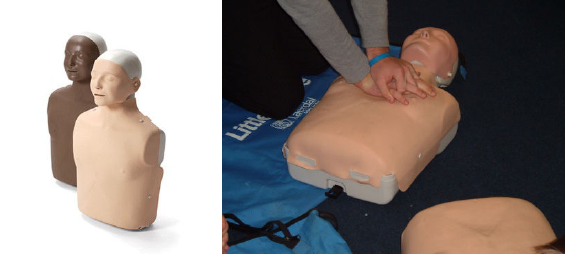
Figure 3. CPR Manikin Laerdal Little Anne (left) and CPR Procedure (right)